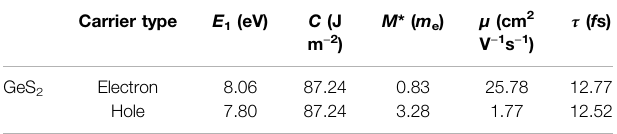
TABLE2| DPconstant E 1 ,elasticconstant C ,effectivemass m *,carriermobility μ , and relaxation time τ of the GeS 2 monolayer at room temperature. m e represents the rest mass of the